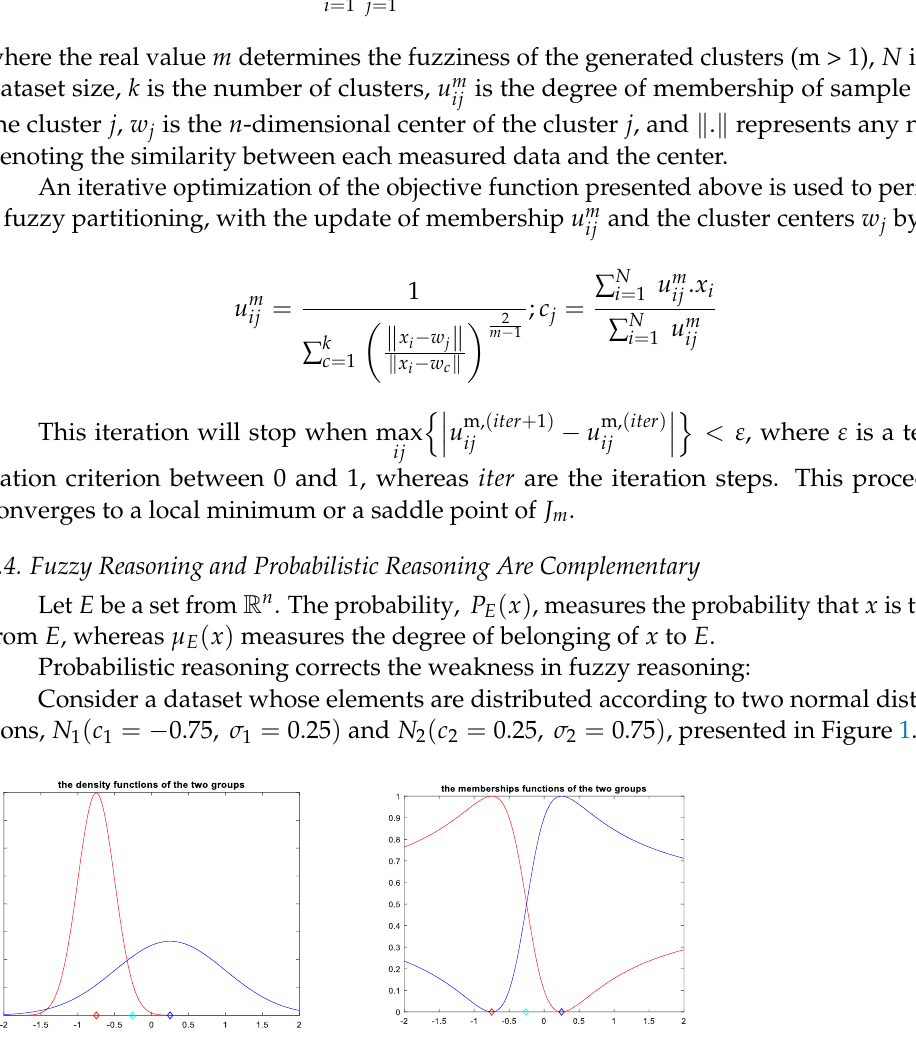
Figure 1. Fuzzy membership functions and probability densities of two clusters associated with N 1 and N 2 red color corresponds to the first group and the blue one corresponds to the second color.